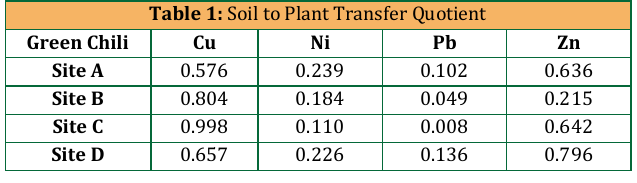
Table 1: Soil to Plant Transfer Quotient